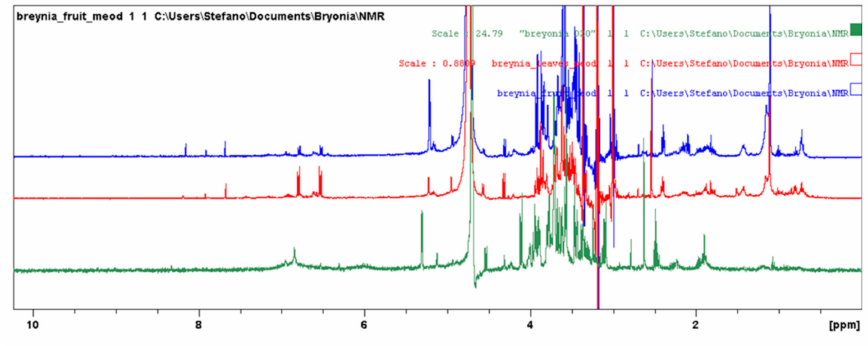
Figure 1. 1 H NMR of Deuterated methanol extract of B. retusa fruits in blue, deuterated methanol extract of B. retusa leaves in red, Deuterated water extract of Breynia in